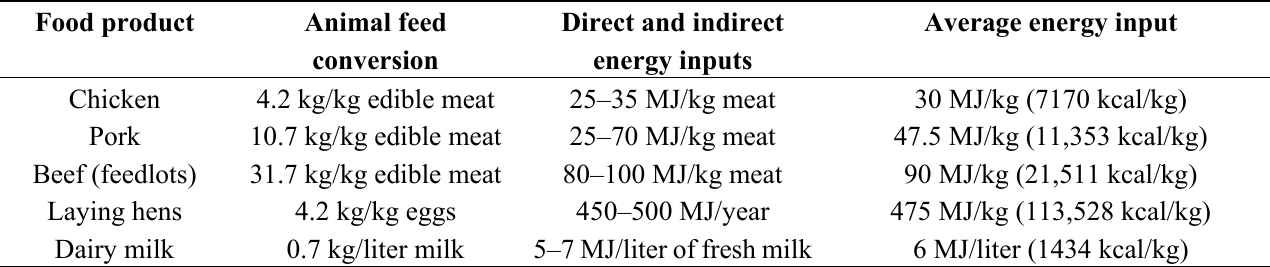
Table 1. Direct and indirect energy inputs into the animal food product